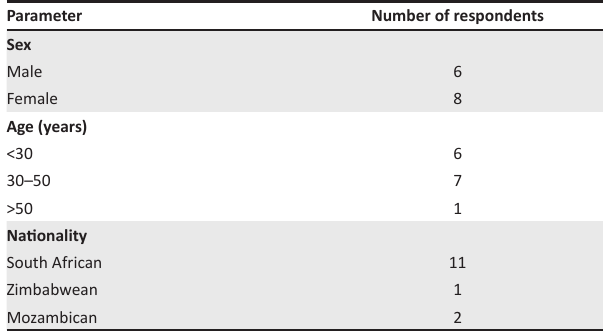
TABLE 2: Profile of the respondents. TABLE 1: Coding themes.